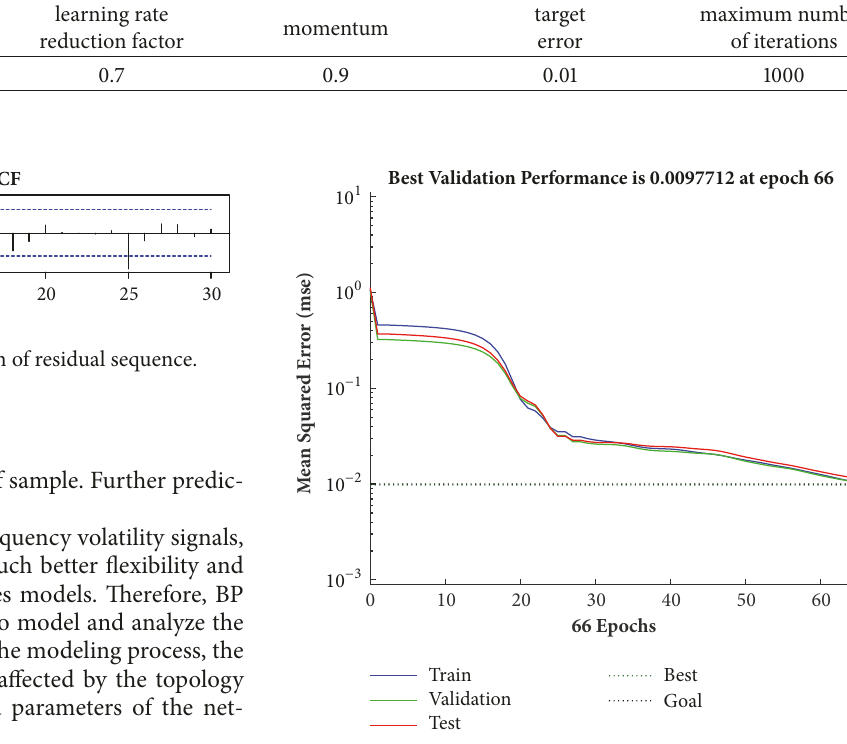
Figure 6: The error characteristic